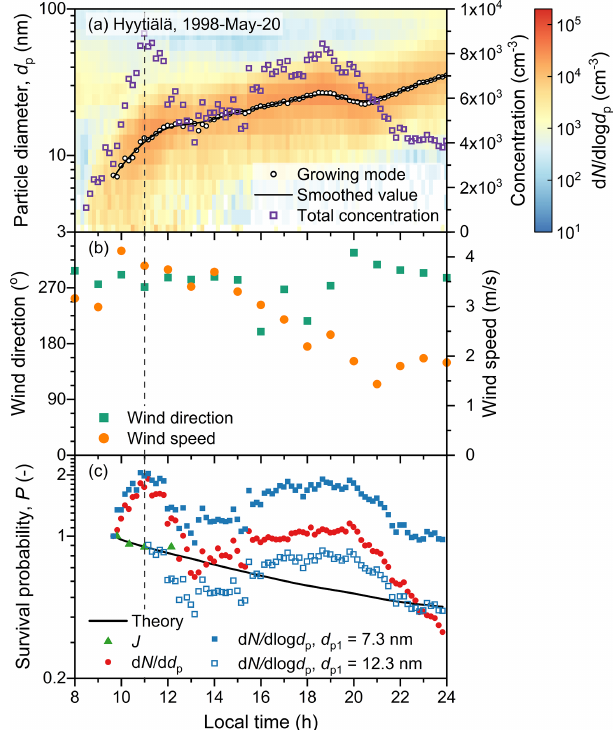
Figure A4. A case study of the influence of atmospheric inho- mogeneity on the measured survival probability of new particles. (a) Measured size distribution of new particles. The representa- tive diameter of the growing mode is obtained using the mode- fitting method. (b) Wind direction and speed measured at 16.8m height. (c) The measured and theoretical survival probability along the mode diameters; d p1 is the initial size for survival probability computation as defined in Eq.